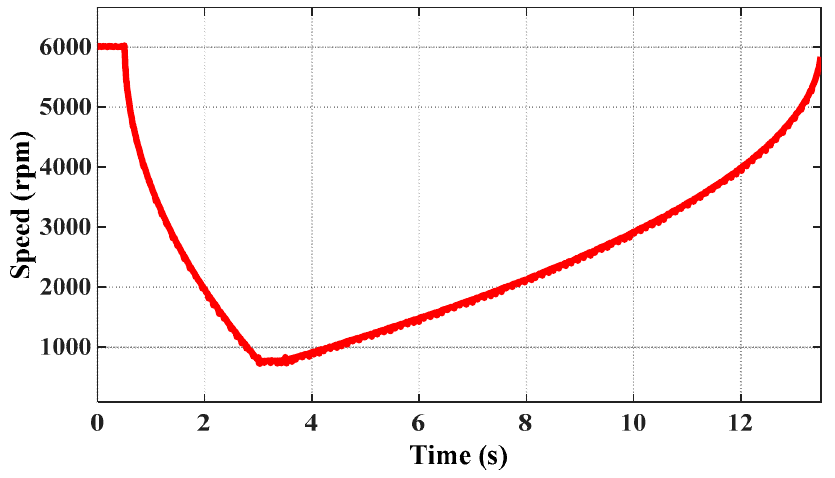
Figure 22. Experimental result for FESS speed.